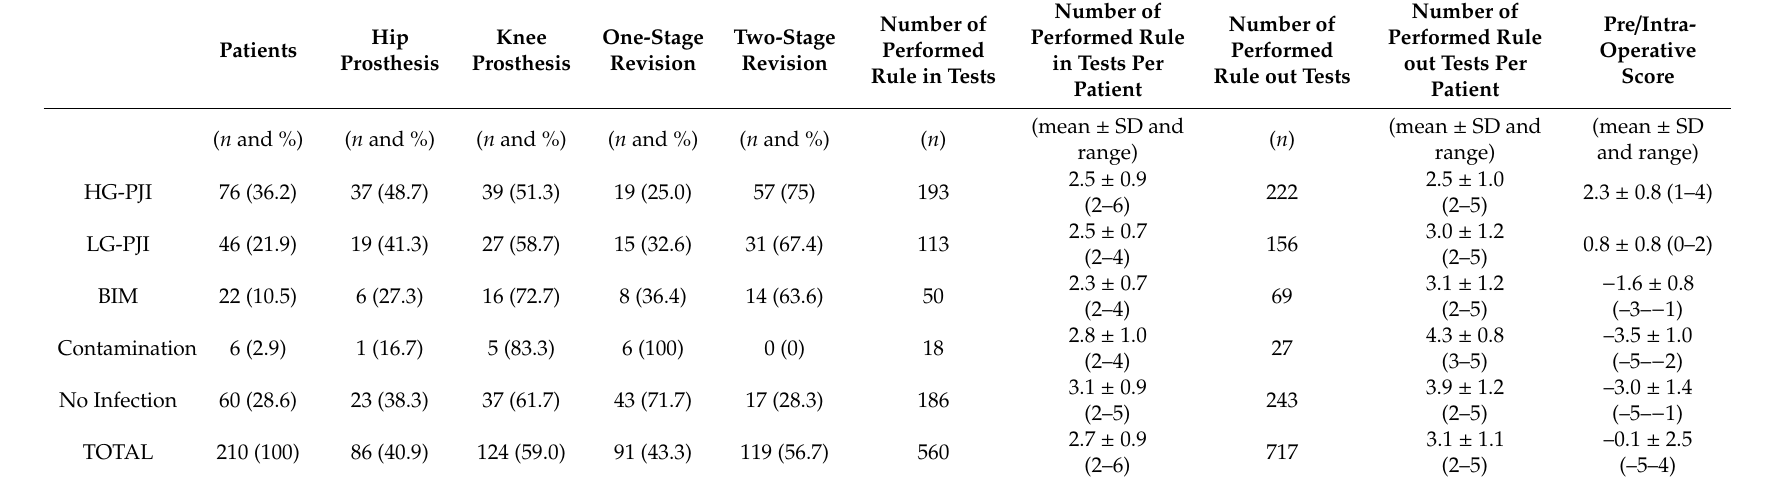
Table 4. Pre / Intra-operative data of the studied